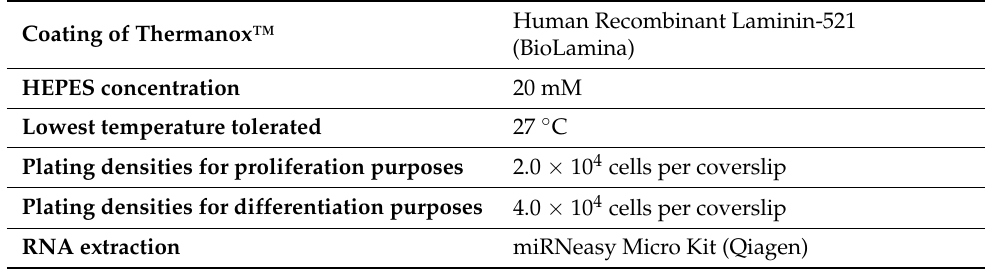
Table 5. Selected parameters to be used with huMPCs to be sent on board the